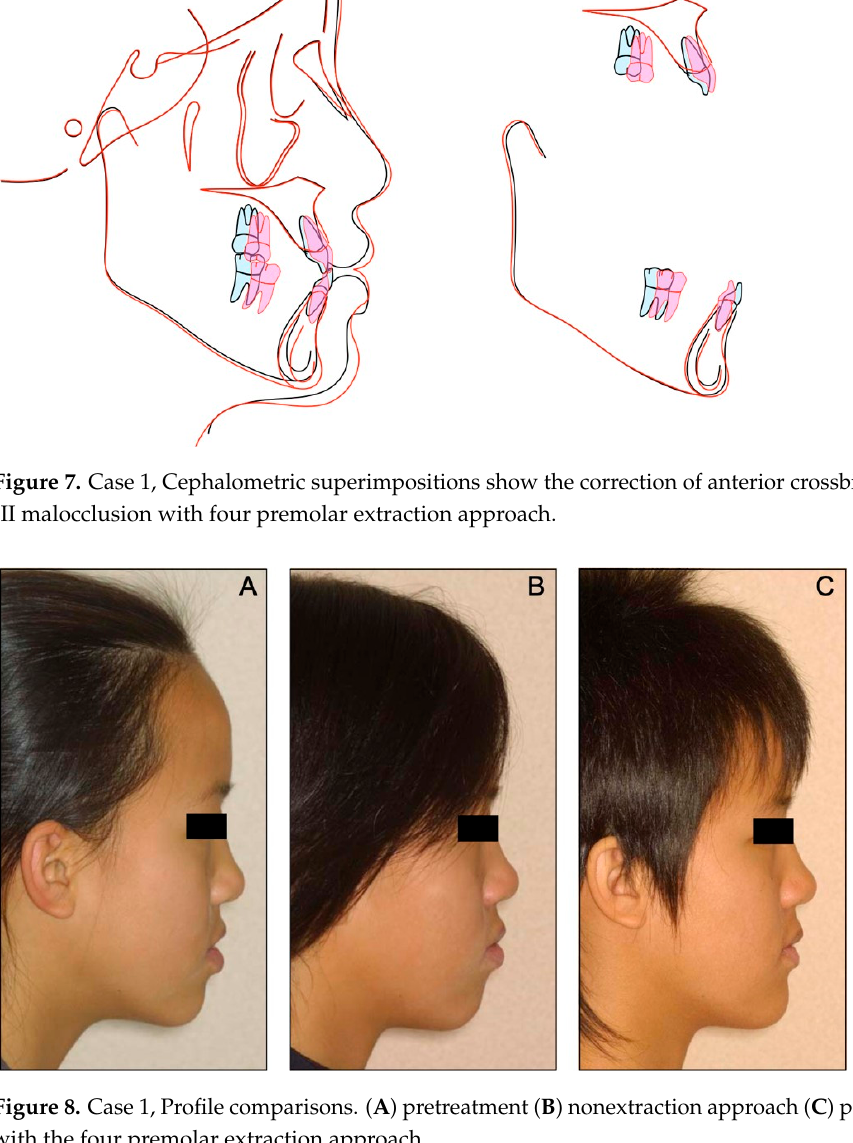
Figure 8. Case 1, Profile comparisons. ( A ) pretreatment ( B ) nonextraction approach ( C ) posttreatment with the four premolar extraction approach.